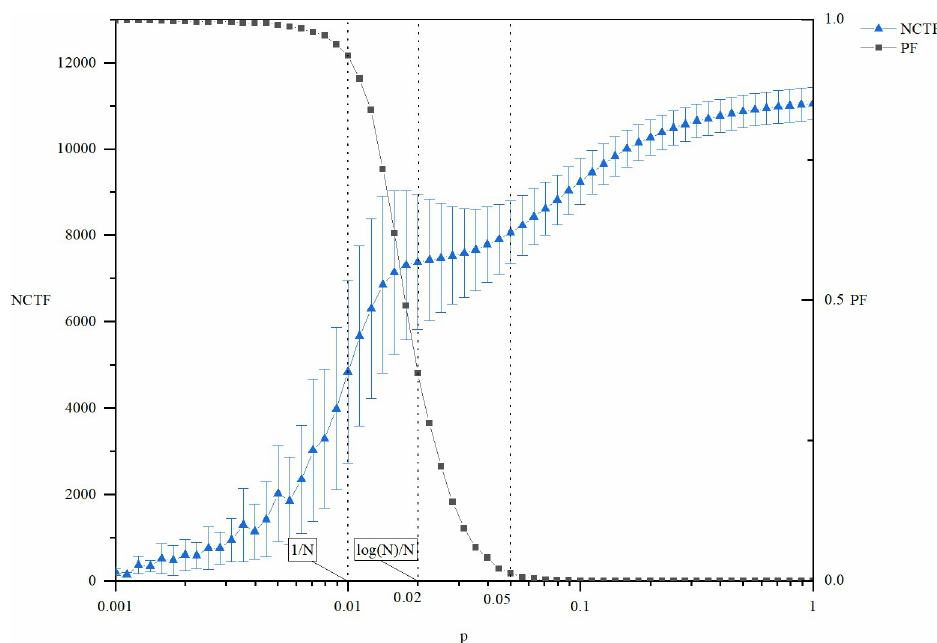
Fig 3. NCTF and PF of exploitative innovation as a function of p.